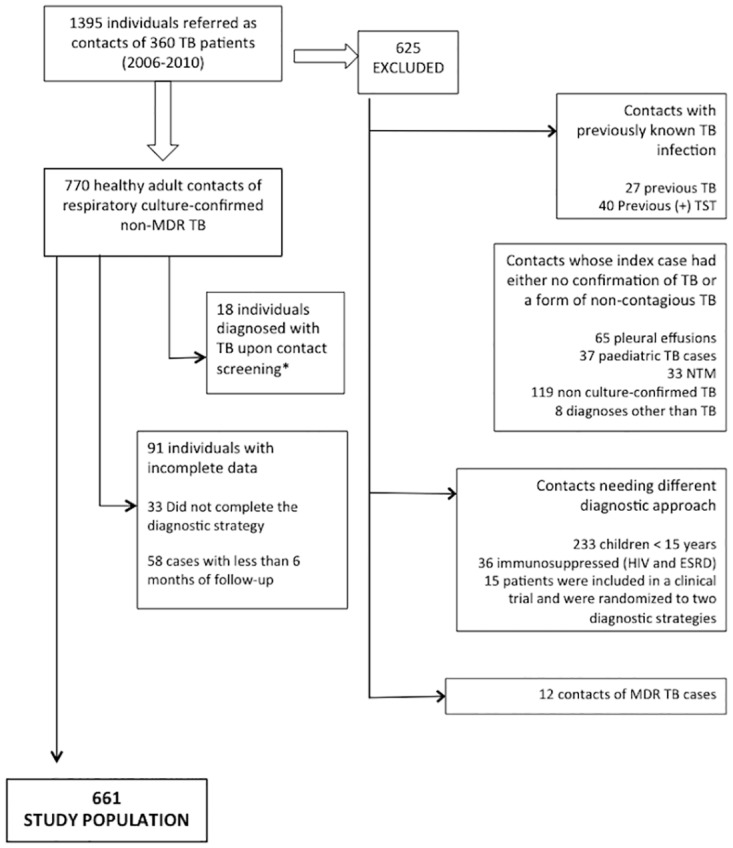
Chart of the contacts included.TB: tuberculosis; HIV: human immunodeficiency virus; MDR: multi-drug resistant; ESRD: end-stage renal disease; TST: tuberculin skin test; NTM: Non-tuberculous mycobacteria. a12 and 6 patients in the first and second period, respectively.